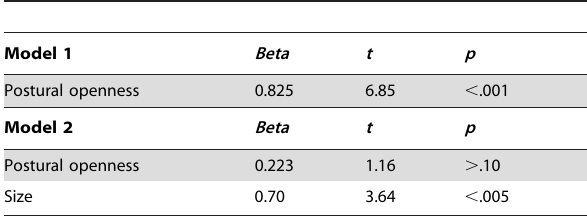
Table 6. Relationship between posture and perceived status after accounting for perceived size in Experiment